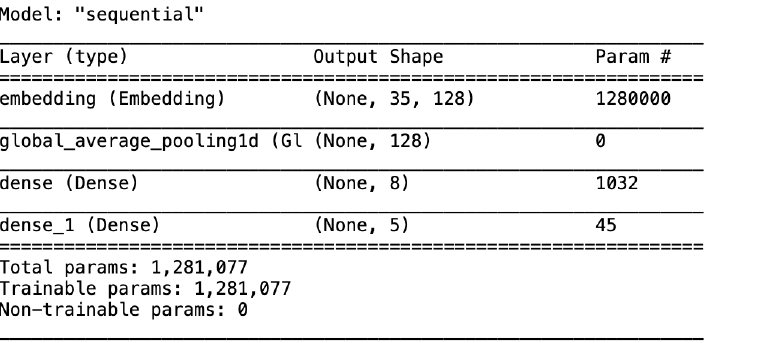
Figure 3. Hyperparameters of MLP